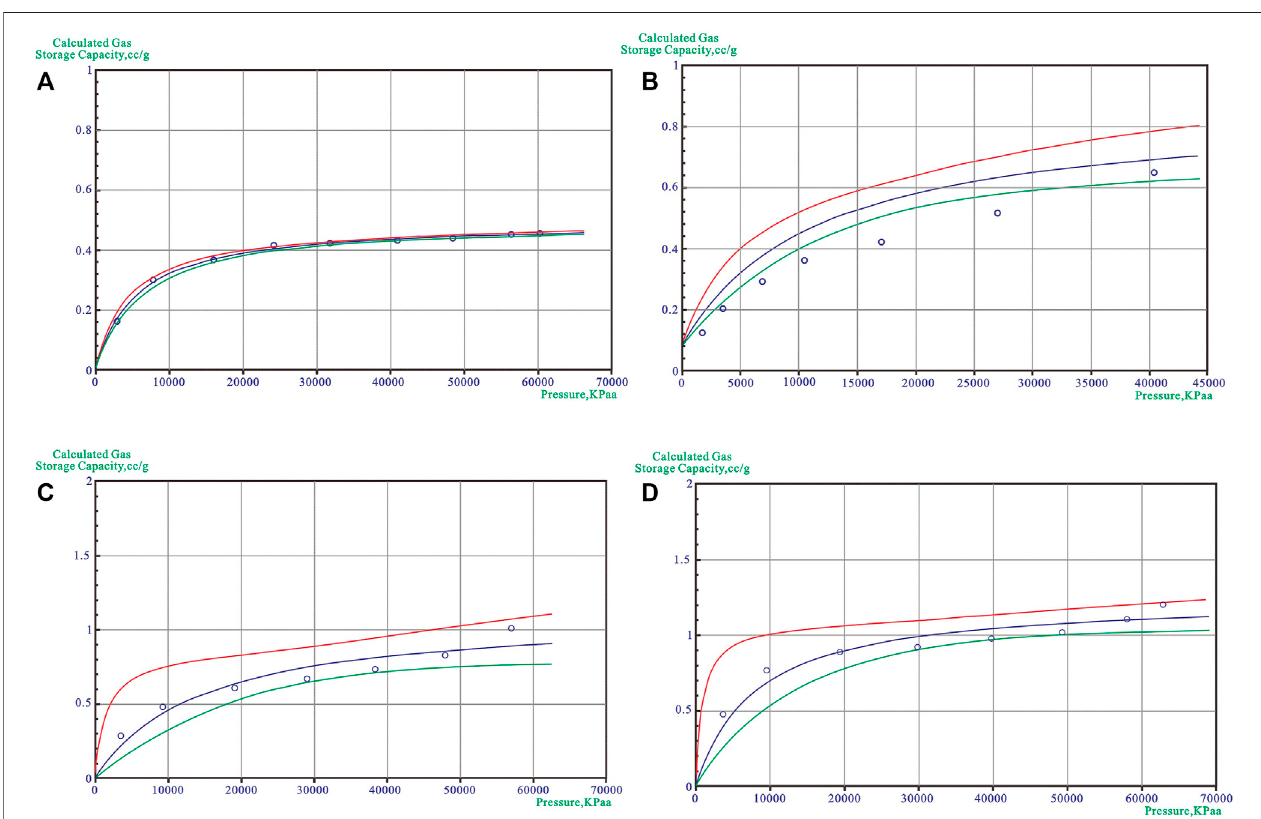
FIGURE 2 | The isothermal adsorption curve. (A) 1-1BM, 2,565.21 m – 2,561.28 m, well X9; (B) 1-4BM, 3,036.75 m – 3,036.85 m, well X9; (C) 1-8BM, 3,057.47 m – 3,057.53 m, well X9; (D) 1-23BM, 3,156.44 m – 3,156.5 m, well X9. The curve showing the data (circle), Langmuir fi t (blue line), Upper 95% Conf. Interval (red line) and Lower 95% Conf. Interval (green line).